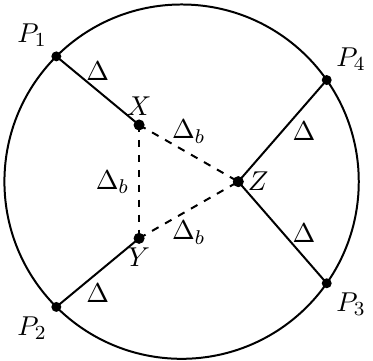
Figure 13. The triangle diagram in